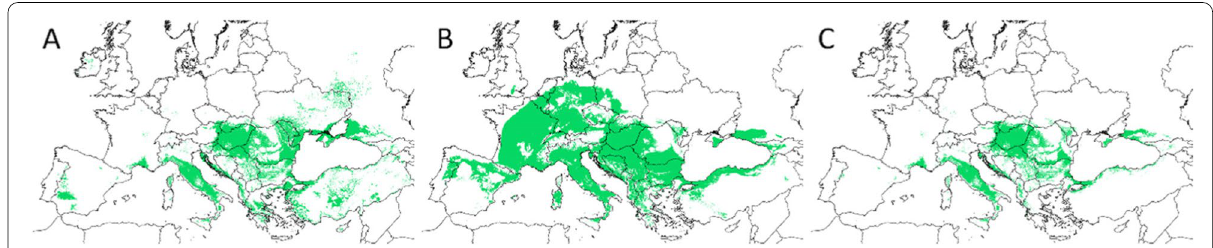
Fig. 2 Example of the estimation phases of the climate envelope for Turkey oak in the case of the reference period (1961–1990): ( A) raw estimate of random forest model, ( B) the potentially predictable area based on the parameter ranges of training areas, ( C) the extrapolation-free real climate envelope estimation after clipping the raw estimate with the predictable